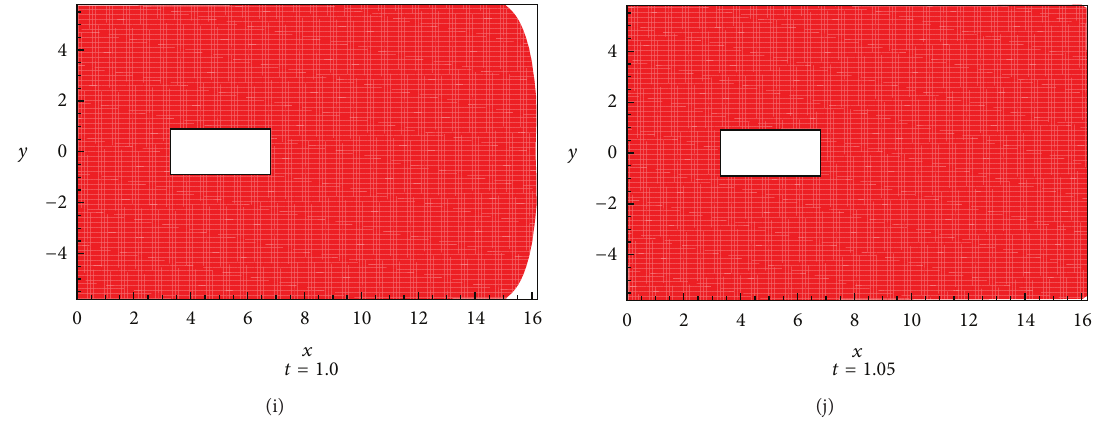
Figure 3: Melt positions at different time in the mold filling